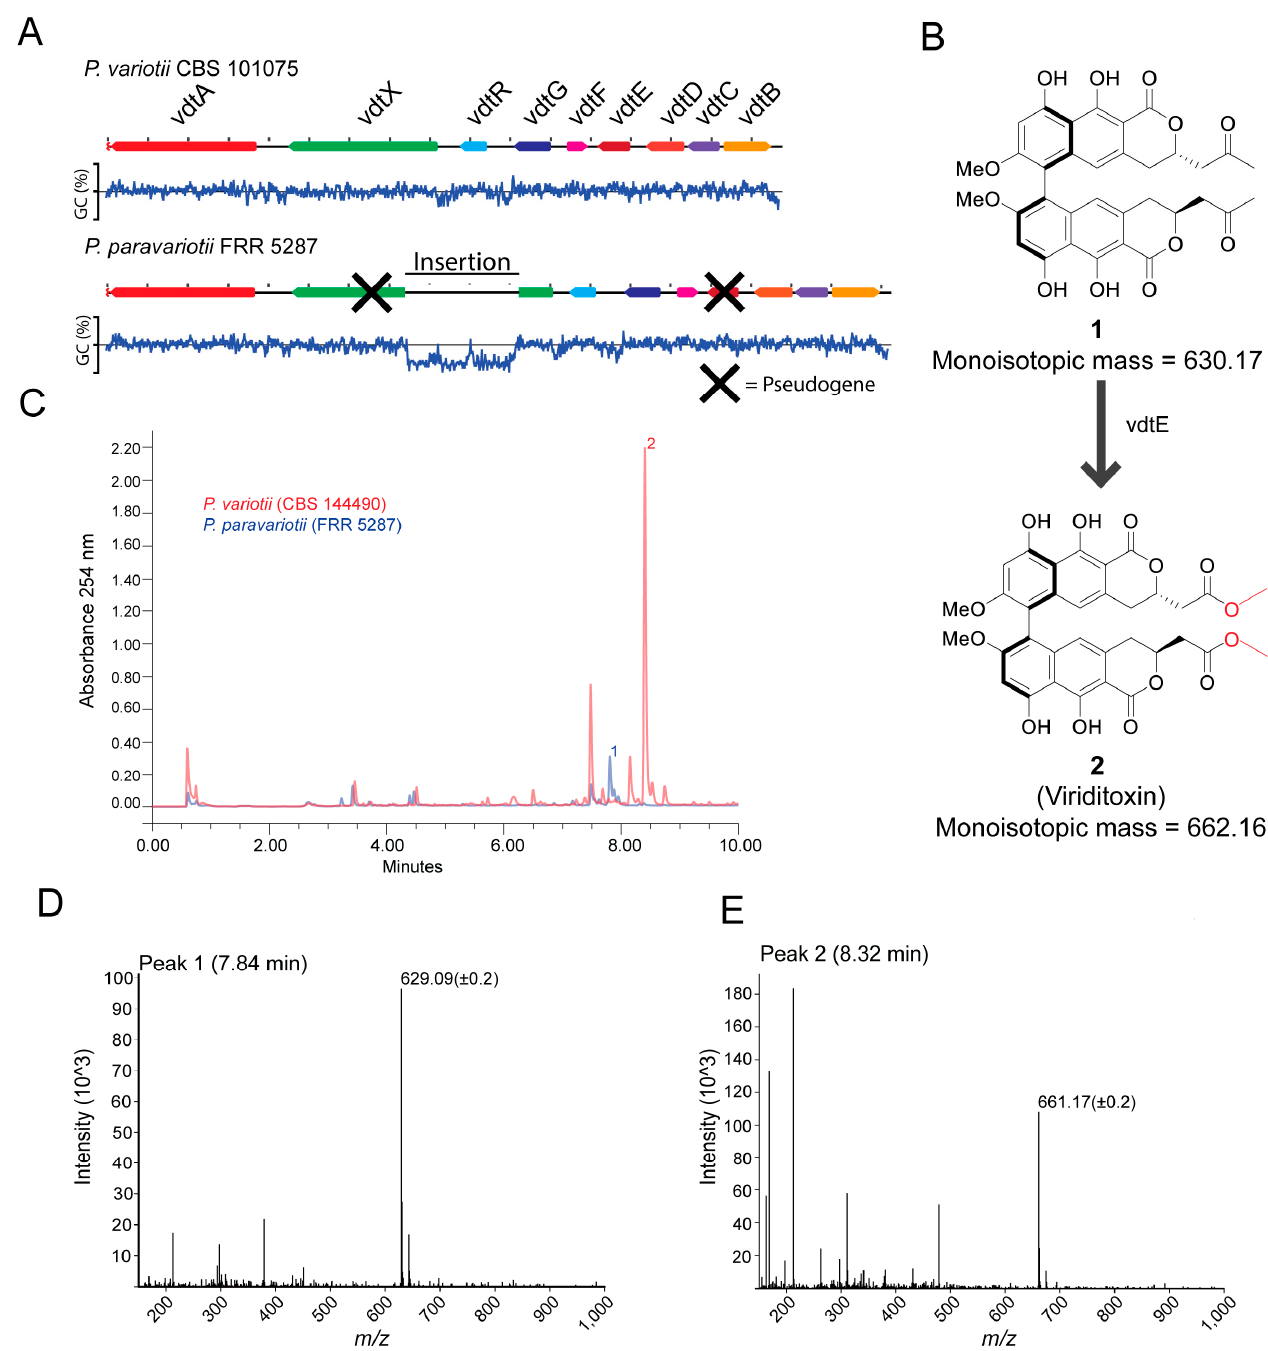
Figure 4. P. paravariotii strain FRR 5287 is unable to synthesis mature viriditoxin. ( A ) FRR 5287 has a mutated viriditoxin biosynthesis cluster in which vdtX and vdtE are pseudogenes. The % GC content across the DNA is graphed below the DNA region. ( B ) vdtE is responsible for the Baeyer–Villiger oxidation in viriditoxin biosynthesis; its absence leads to the production of compound 1 rather than viriditoxin 2 . ( C ) HPLC-MS data showed the production of 1 in FRR 5287. The mass spectra for ( D ) compound 1 and ( E ) compound 2 .